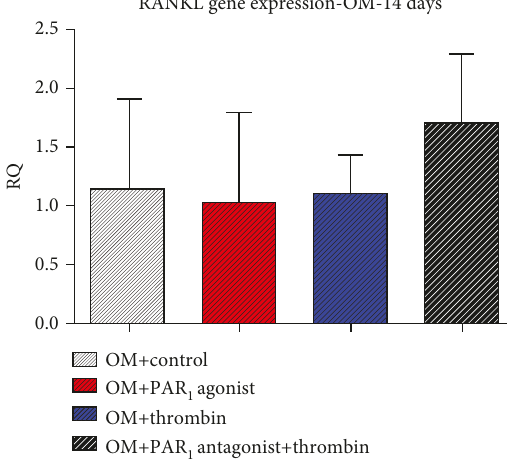
Figure 7: E ff ects of PAR activation on RANKL gene expression at 1 14 days, in the osteogenic medium. Values are presented as mean and SEM; n = 3 .